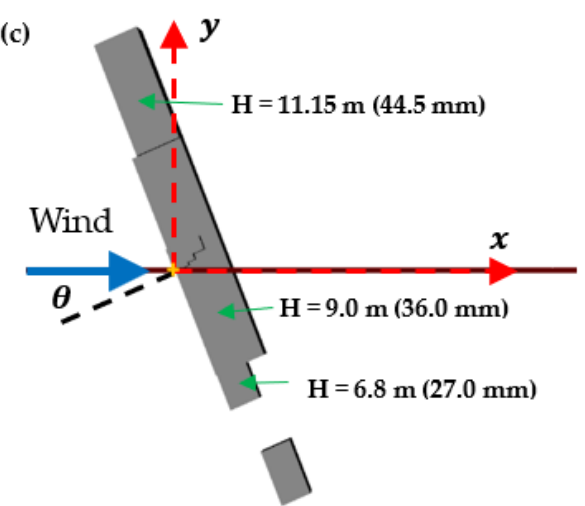
Figure 2. ( a ) Experimental model of the building; ( b ) Layout in wind tunnel; ( c ) Heights, wind incidence and Cartesian coordinate system definition (“+” denotes origin point).